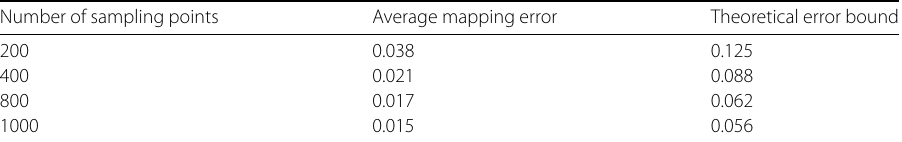
Table 1 Convergence of the ray mapping algorithm Number of sampling points Average mapping error Theoretical error